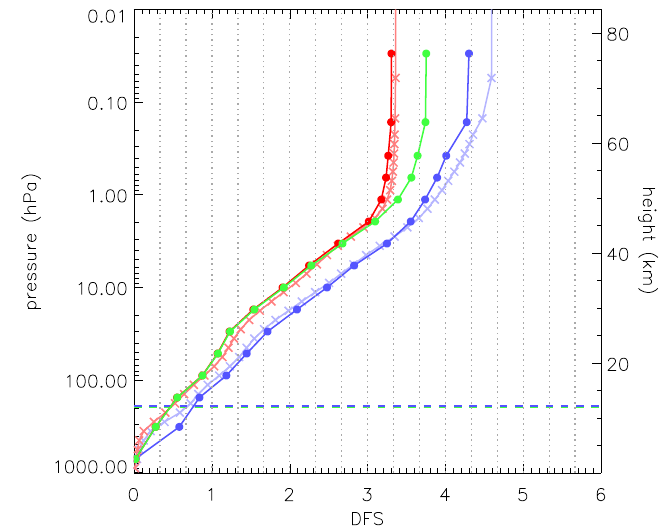
Fig. 1. The cumulative DFS for a GOME observation on 26 May 1997 (blue) and for GOME-2 on 4 April 2008 (red) over Europe. The lines marked with crosses are the DFS for a high-resolution, 40-layer retrieval grid, while the lines marked with dots are the DFS for a retrieval on the 16-layer grid (see Table 2). The green line represents the same observation from GOME-2, but is retrieved without the additive offset. The horizontal dashed line is the thermal